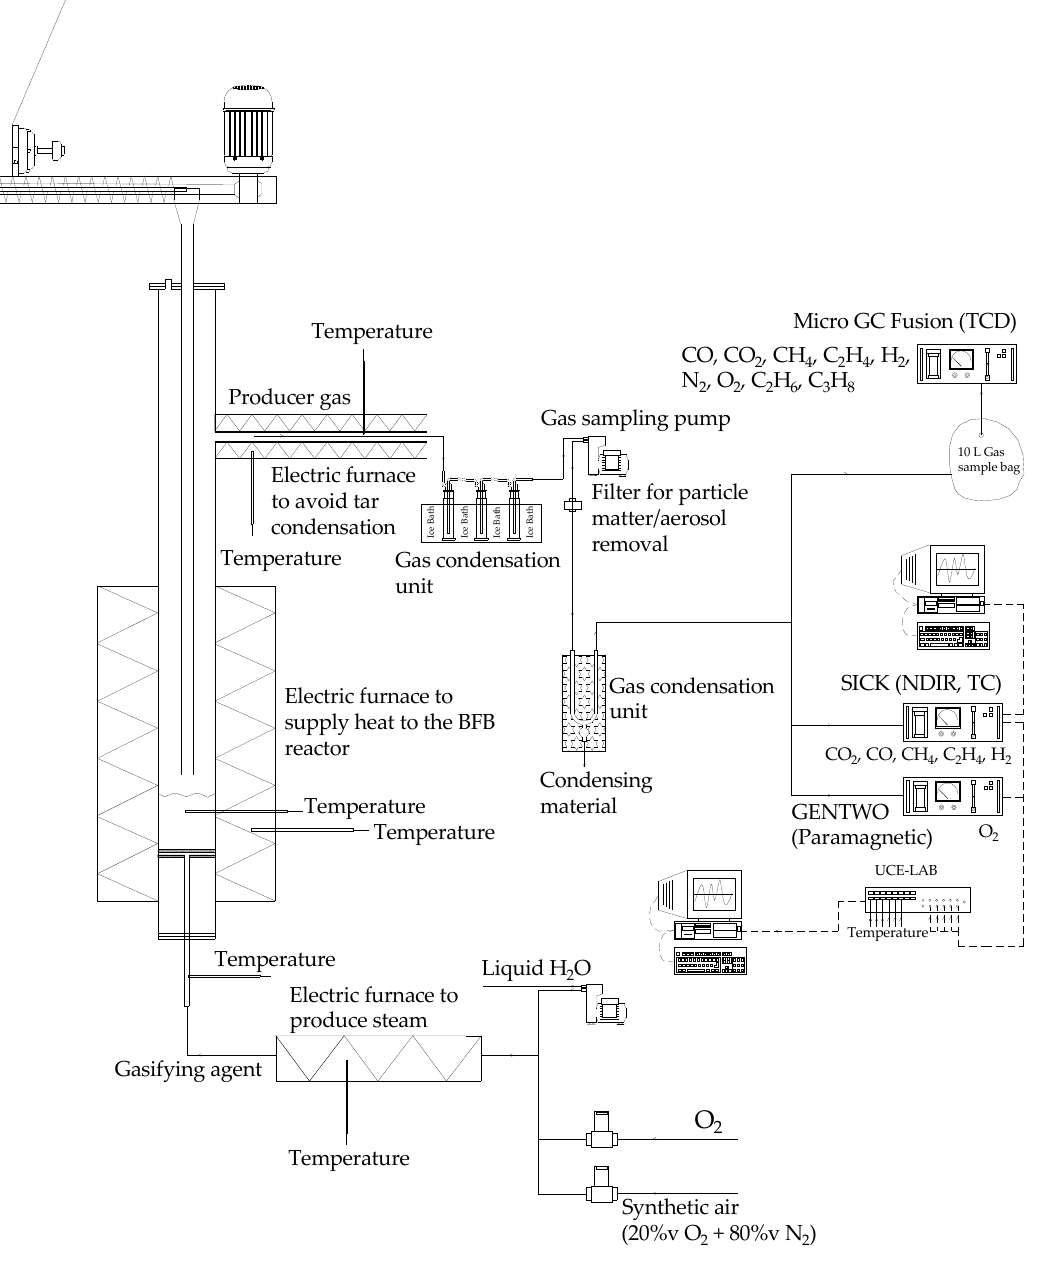
Figure 1. Schematic layout of the bench-scale 3 kW th externally heated BFB gasifier. Dashed line— Electric circuit, Continuous line—Pneumatic circuit, GENTWO—Paramagnetic online gas analyzer for O 2 , UCE-LAB—Electronic command unit, Micro GC Fusion—Gas chromatograph with Thermal Conductivity Detector (TCD), SICK online analyzer with nondispersive infrared (NDIR) sensor and thermal conductivity (TC) sensor (adapted from [19]). The bed material was quartz sand (150 g, particle size between 180–250 μ m). The flow rate of dry synthetic air—20 %vol O 2 in N 2 , hereinafter referred to as “air”—and O 2 were adjusted with two mass-flow controllers—Bronkhorst, Prestige model—measuring in a range of 0 to 10 NL ∙ min − 1 and 0 to 1 NL ∙ min − 1 , respectively. The steam flow rate was pro- duced and controlled by pumping liquid water, with a high-performance liquid